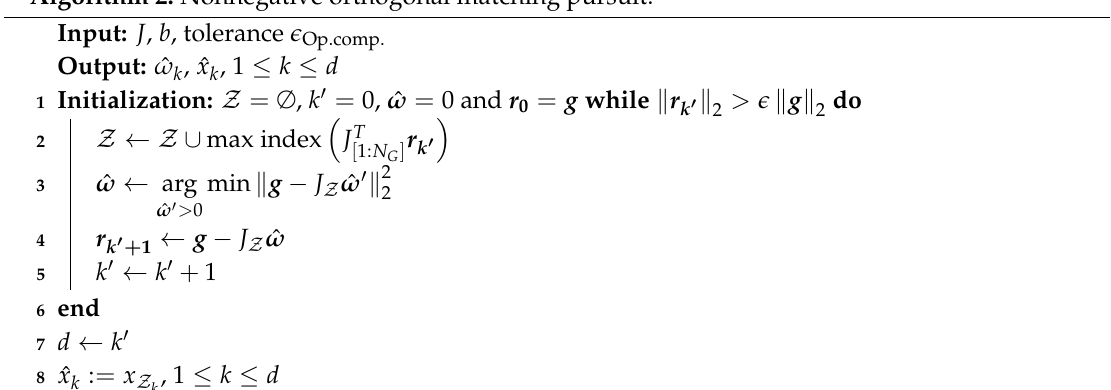
Algorithm 2: Nonnegative orthogonal matching